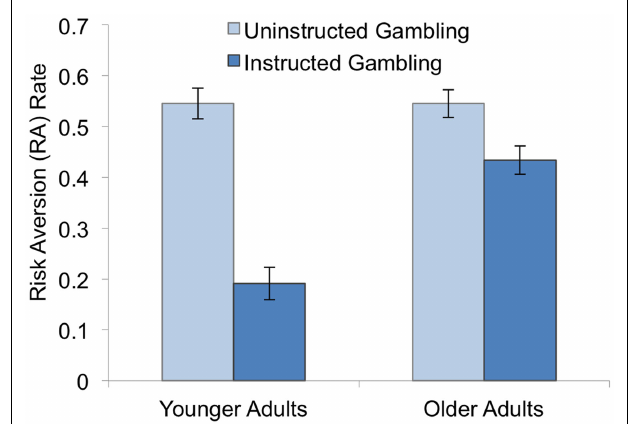
FIGURE 2 | Influence of age and EV-strategy training and instruction on average rate of RA. Strategy practice and instruction reduces RA but less so among older